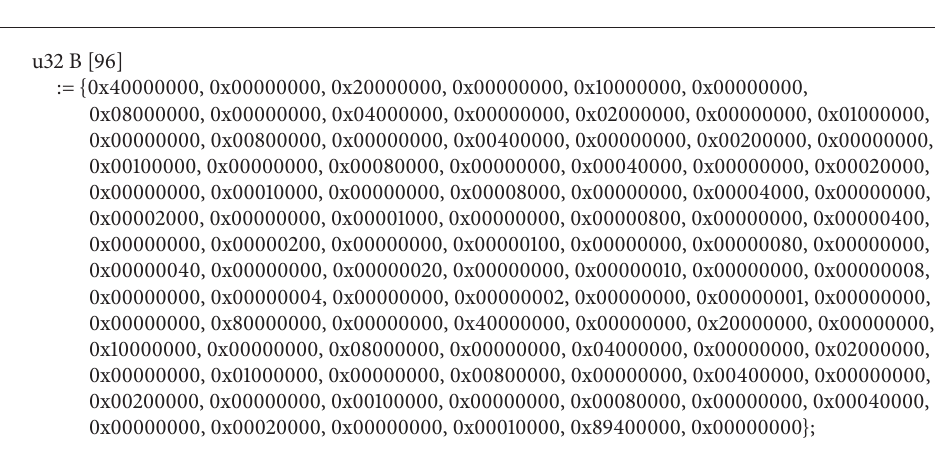
Algorithm 6: Initial contents for matrix 𝐵